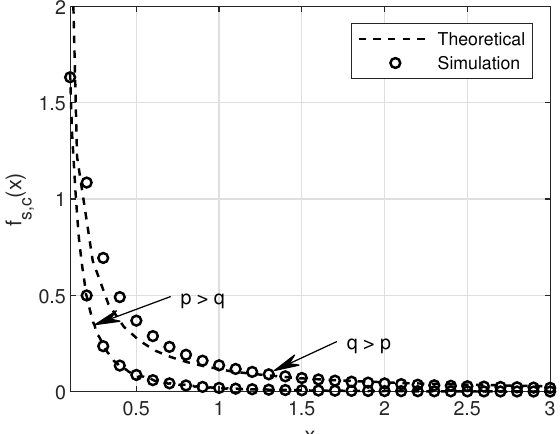
Figure 5. Theoretical and simulation plot of signal to interference and noise ratio (SINR) in collision case with a) p = 10 dB and q = 1 dB (i.e., p > q ) and b) p = 1 dB and q = 10 dB (i.e., q > p ).